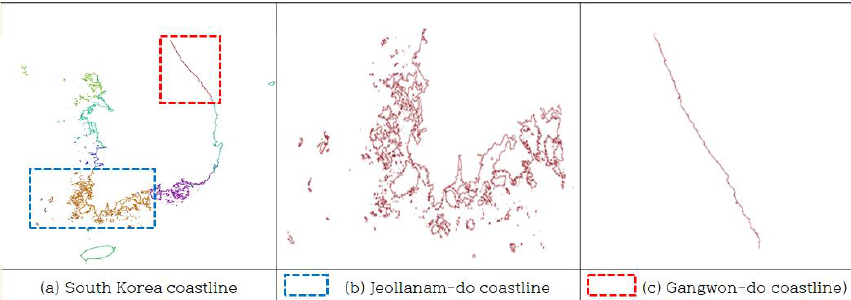
Figure 1. Coastline for test area (a. South Korean coastline, b. Jeollanam-do coastline, c. Gangwon-do